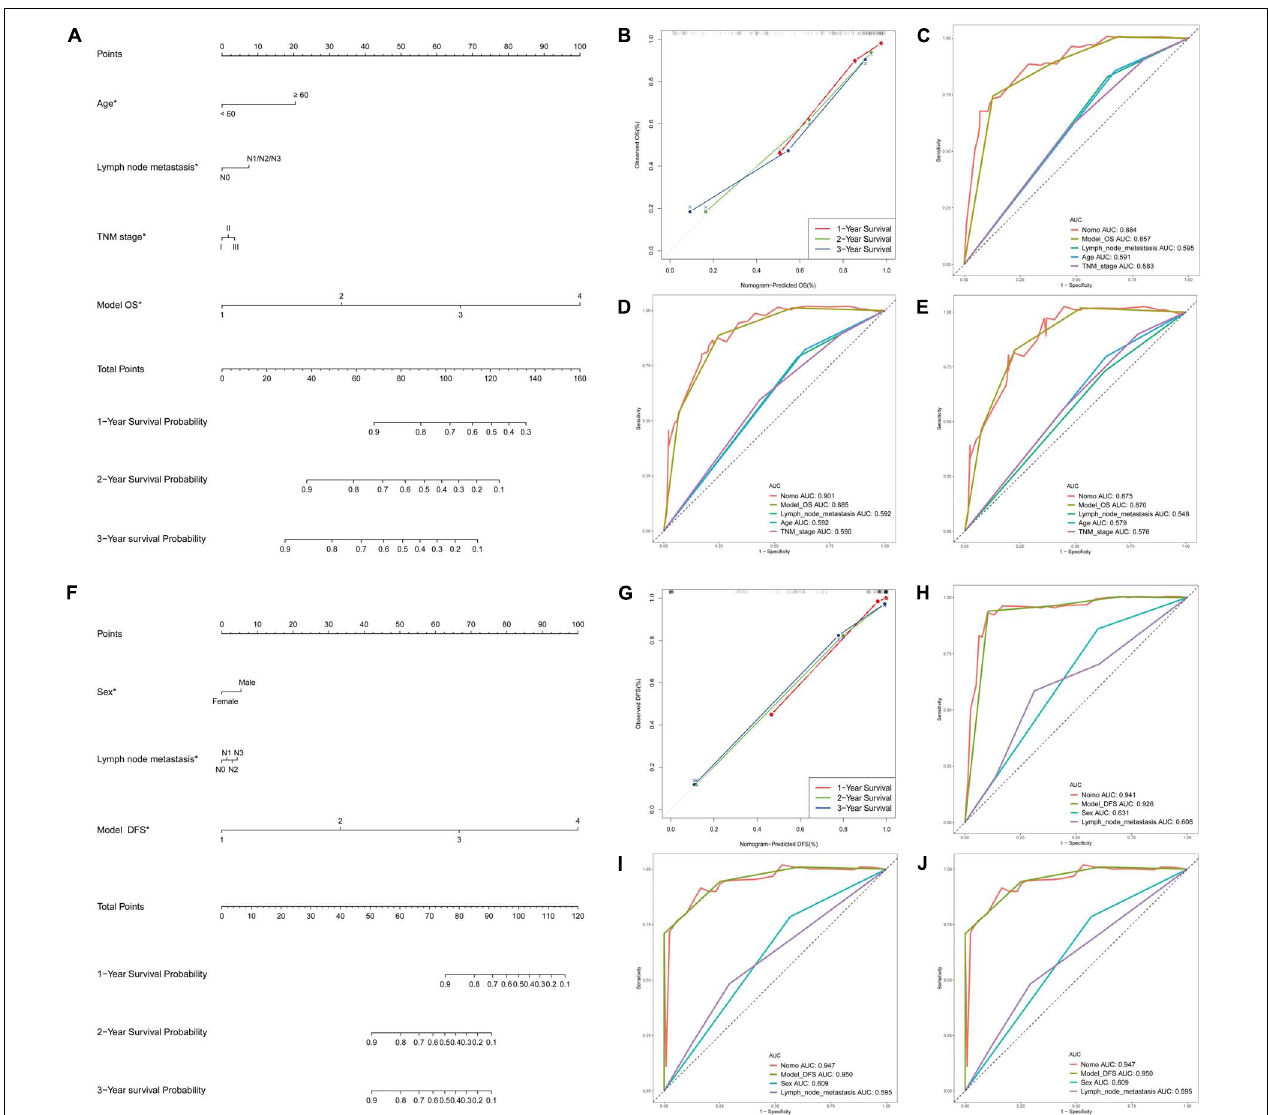
FIGURE 7 | DEAS associated clinicopathologic nomogram for prediction of survival probability in GC patients. (A) Development of DEAS associated clinicopathologic nomogram for predicting 1-, 2-, and 3-year OS for GC patients, with age, lymph node metastasis, TNM stage and OS model. (B) The calibration curves of 1-, 2-, and 3-year OS nomogram prediction in the GC cohort. The y-axis showed the observed OS, and the red, blue and green line indicated the respective performance of the nomogram with 1-, 2-, and 3-year outcomes in the GC cohort. (C–E) ROC curves with calculated AUCs of prognostic signatures built by clinical features, AS prognostic model and the nomogram for risk prediction from 1 to 3 years. (F) Development of DEAS associated clinicopathologic nomogram for predicting 1-, 2-, and 3-year DFS for GC patients, with sex, lymph node metastasis, and DFS model. (G) The calibration curves of 1-, 2-, and 3-year DFS nomogram prediction in the GC cohort. The y -axis showed the observed OS, and the red, blue and green line indicated the respective performance of the nomogram with 1-, 2-, and 3-year outcomes in the GC cohort. (H–J) ROC curves with calculated AUCs of prognostic signatures built by clinical features, AS prognostic model and the nomogram for risk prediction from 1 to 3